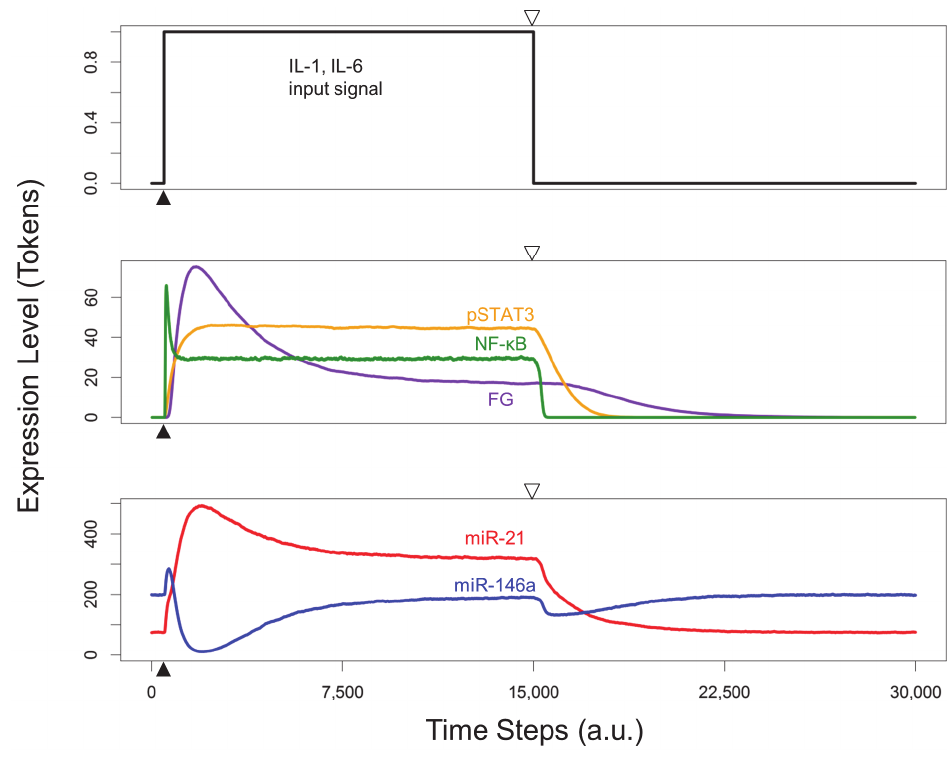
Figure 7. Dynamics of microRNA and transcription factor expression levels during re-quiescence. Solid arrowheads denote the introduction of input cytokine signals. Hollow arrowheads denote the cessation of cytokine